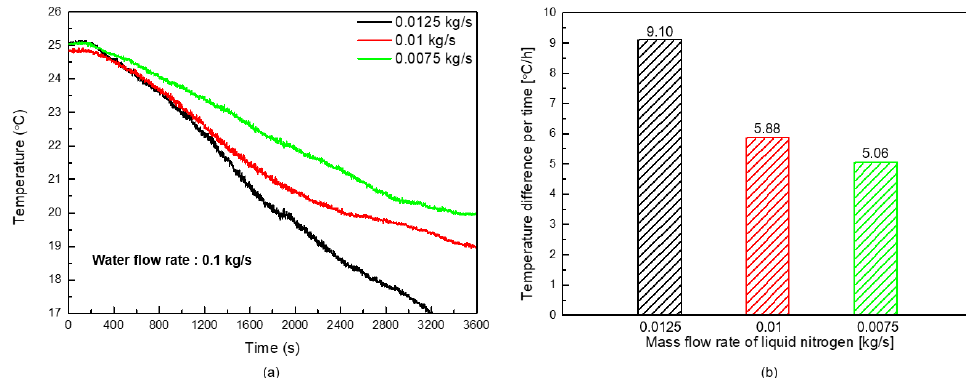
Figure 6. Results of water temperatures ( a ) and water cooling performance in the farming tank at different liquid nitrogen mass flow rates ( b ).